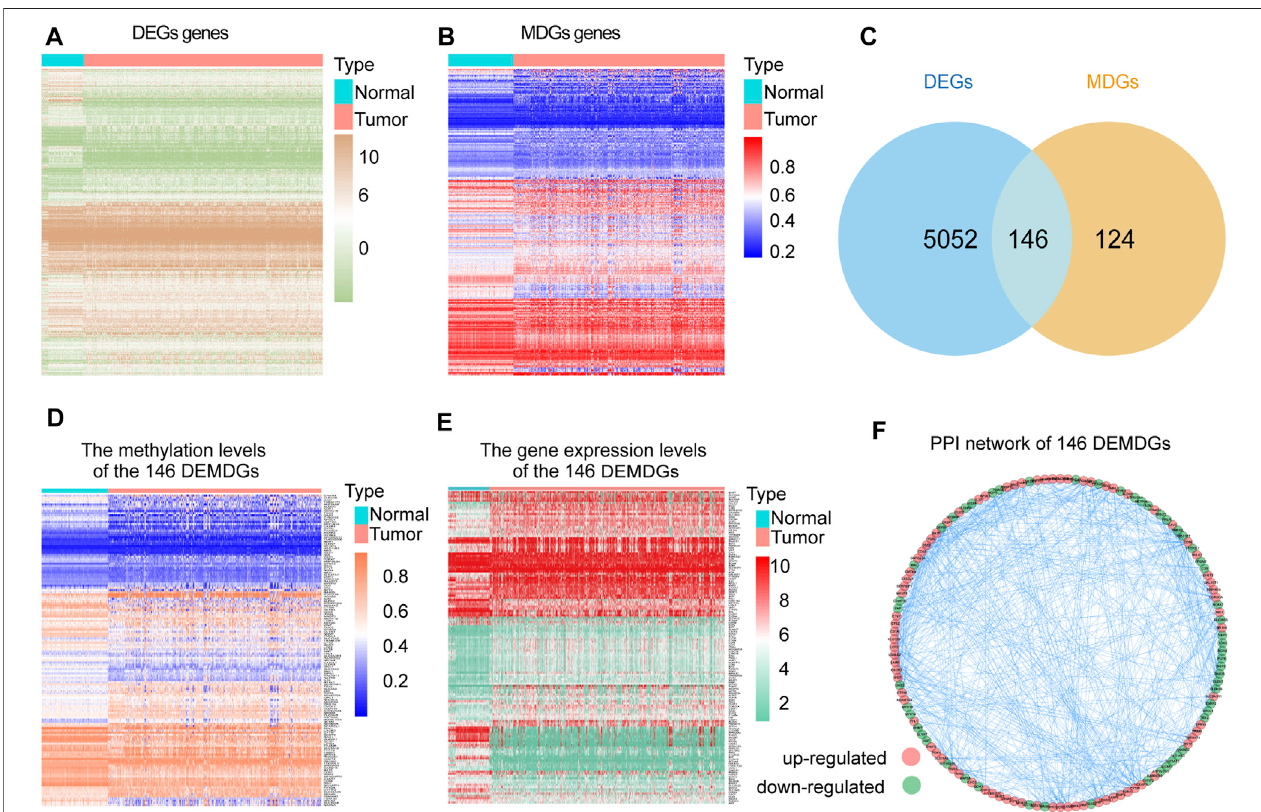
FIGURE2| Screeningof146DEMDGs. (A) Heatmap ofDEGsinnormalsamplesand RCCsamples. (B) Heatmap ofMDGs innormalsamplesandRCC samples. (C) Venn diagram for 146 DEMDGs in normal samples and RCC samples. The blue circle represents 5,198 DEGs, and the yellow circle represents 270 MDGs. (D) Heatmap of methylation levels of 146 DEMDGs. (E) Heatmap of gene expression levels of 146 DEMDGs. (F) PPI network of 146 DEMDGs.